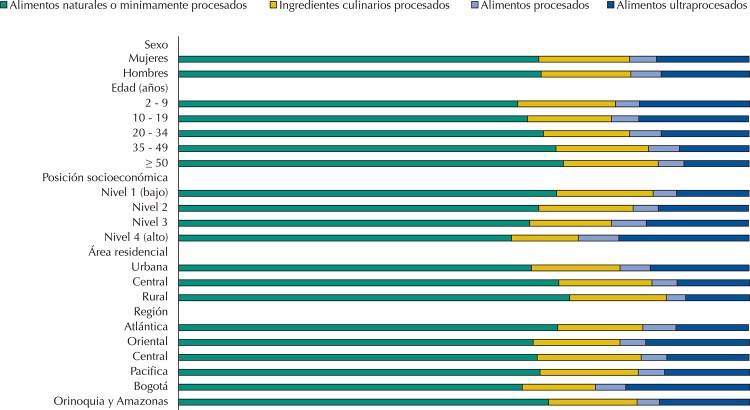
Distribución de la ingesta total de energía según clasificación NOVA y determinantes sociodemográficos. Colombia, 2005.